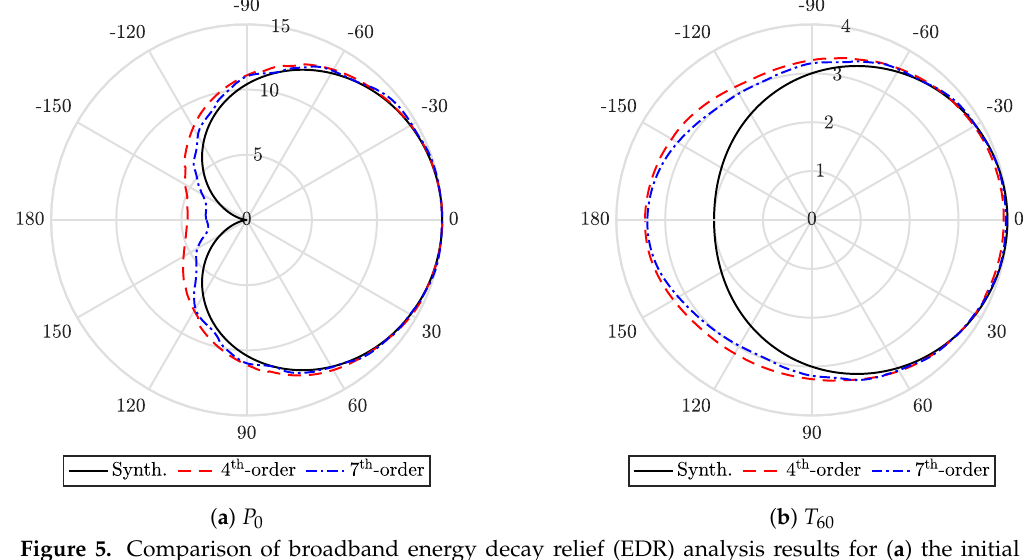
Figure 5. Comparison of broadband energy decay relief (EDR) analysis results for ( a ) the initial spectrum P 0 and ( b ) the reverberation time T 60 (red dashed and blue dash-dot lines for 4th-order and 7th-order analyses, respectively), with respect to the cardioid distributions used to synthesize the simulation (black solid lines). Projection onto azimuthal plane by spherical interpolation; radii represent ( a ) dB and ( b )